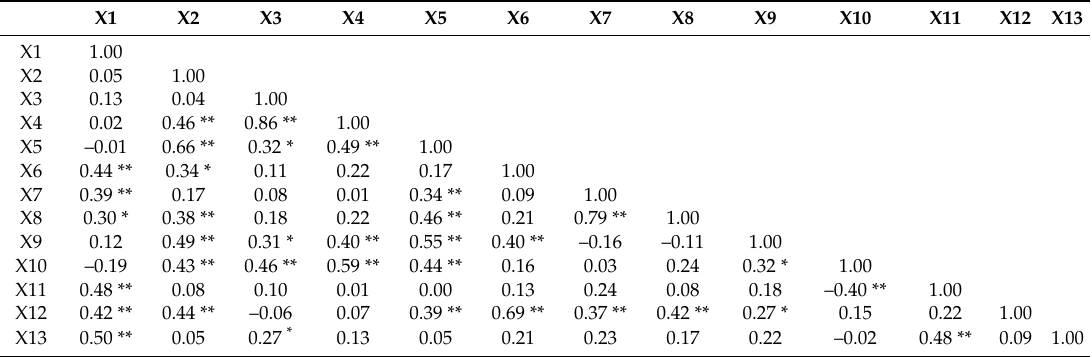
Table 4. Correlations for driving